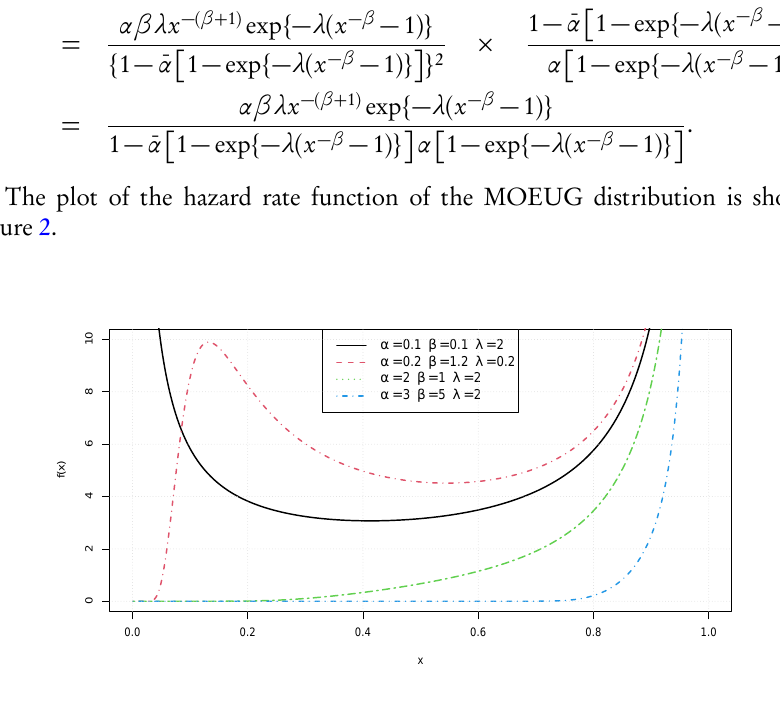
Figure 2 – Hazard rate function of the MOEUGD for different values of the parameters. The plot indicates that the hazard rate function of the MOEUG distribution acco- modates an increasing, bathtub, and upsidedown bathtub shaped